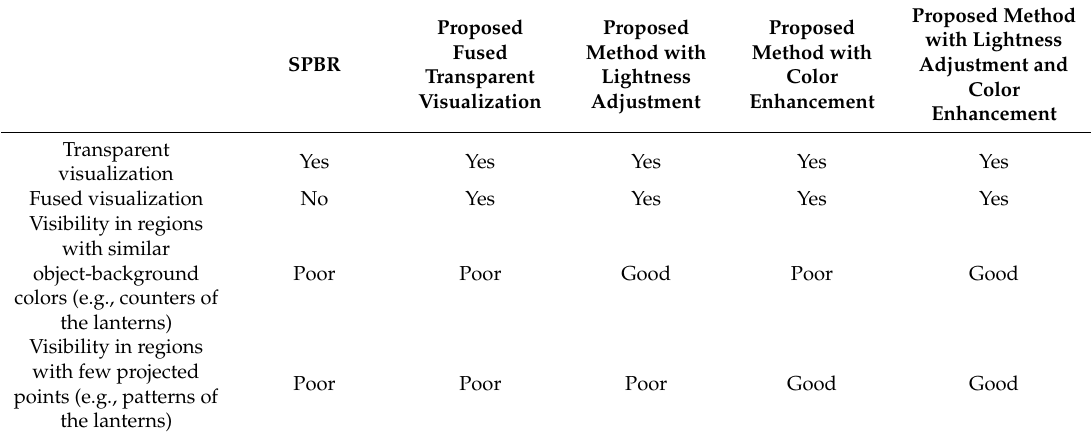
Table 2. Overview of the conventional SPBR (Stochastic Point-Based Rendering) and the proposed method. Transparent visualization